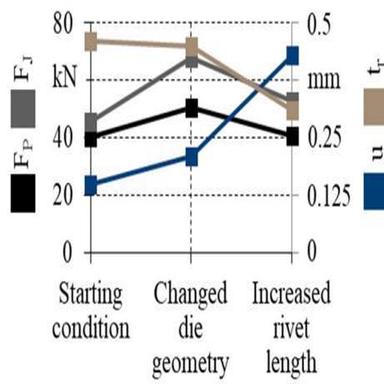
Change in joint and process characteristic in dependence on the die geometry and the rivet length.